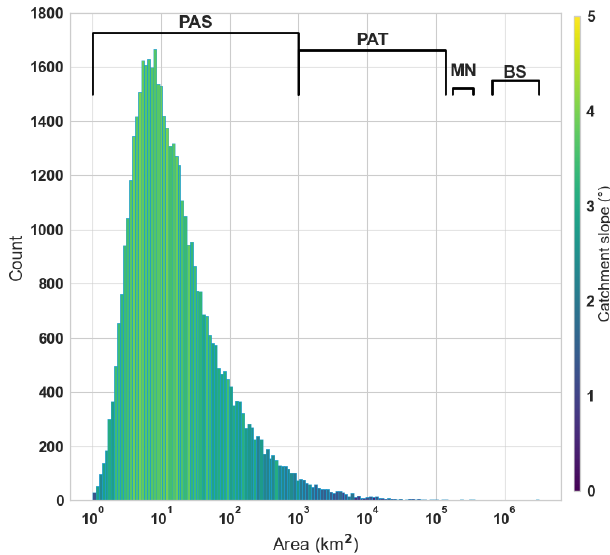
Figure 2. The distribution of watershed areas in the pan-Arctic wa- tersheds database and the range of the four groups that are classified based on watershed area. “BS” stands for “Big Seven”, “MN” for “Middle Nine”, “PAT” for “Pan-Arctic Thousands”, and PAS for “Pan-Arctic Small watersheds”. Note that the x axis has a logarith- mic scale. The colors represent the mean catchment slope of the